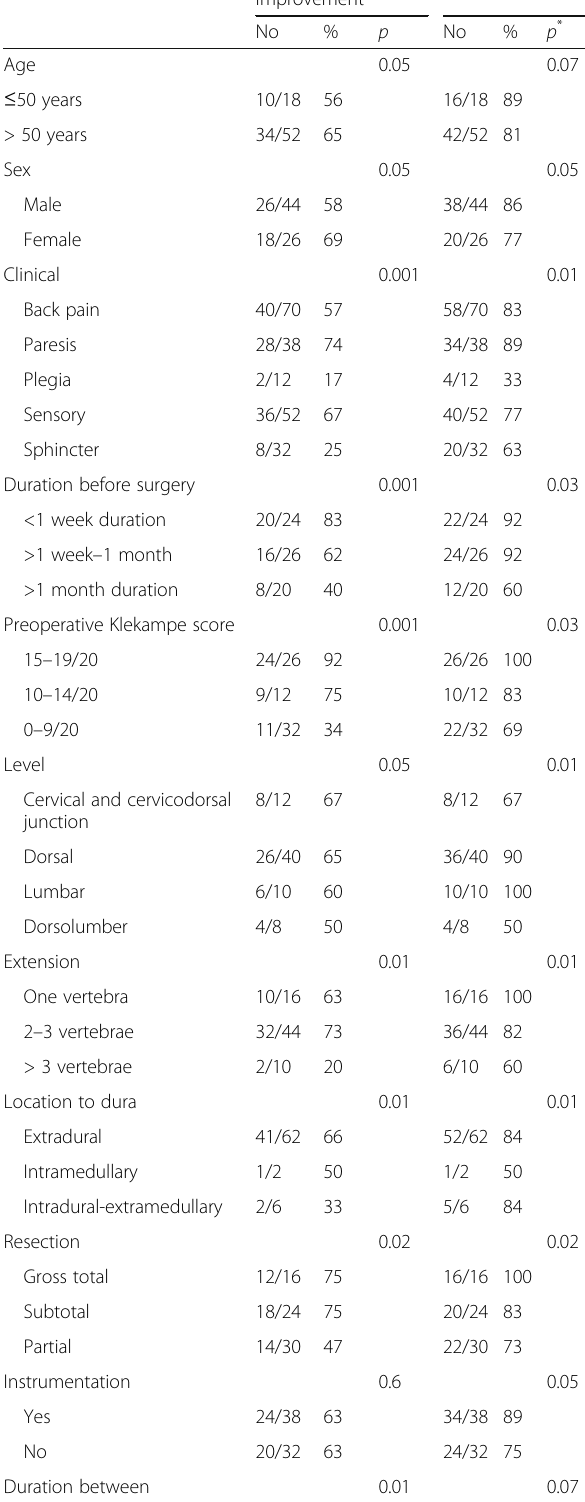
Table 8 Ninth month postoperative outcome (Klekampe score improvement and survival)